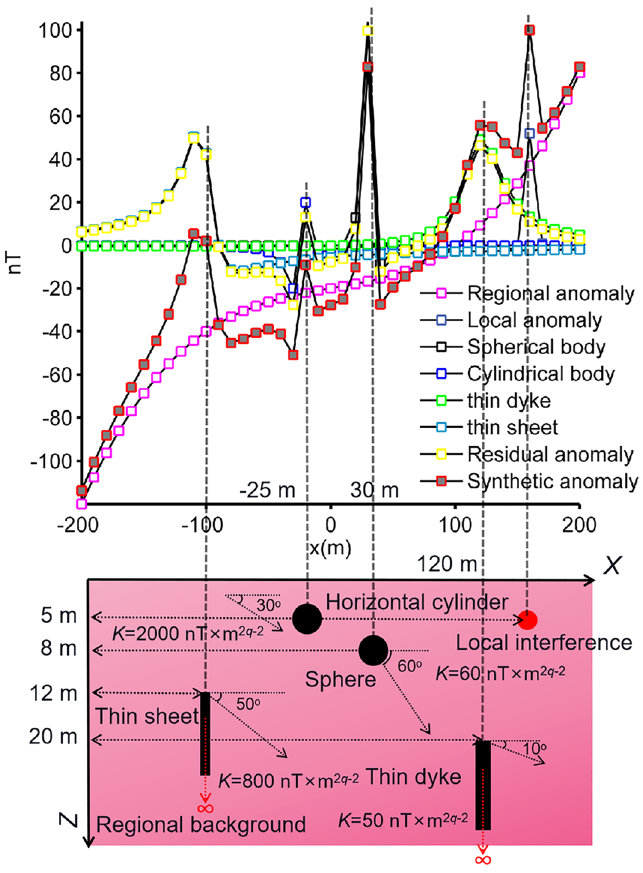
Figure 7. Synthetic residual magnetic anomaly of the multiple-source model (case 2) superposed on a regional background and local interference, and the causative subsurface